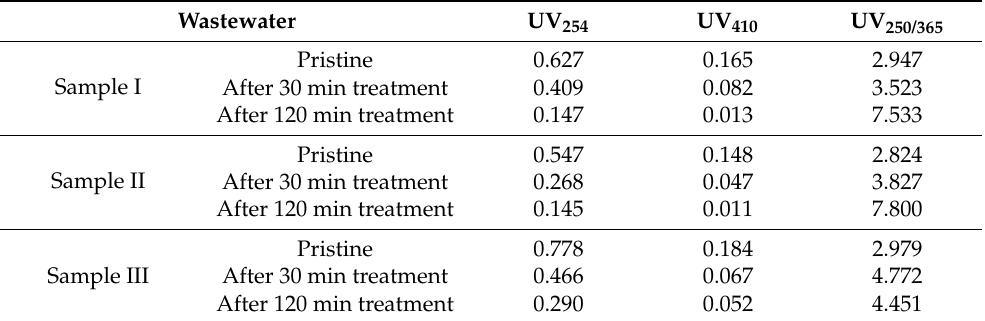
Table 3. UV-vis indicators of swine wastewater by Ti 4 O 7 anode at 50 mA/cm 2 current density.